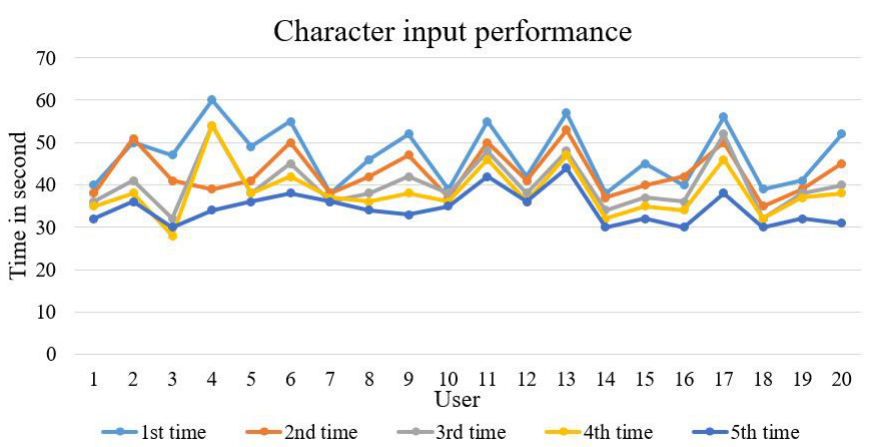
Figure 15. Character input performances of all